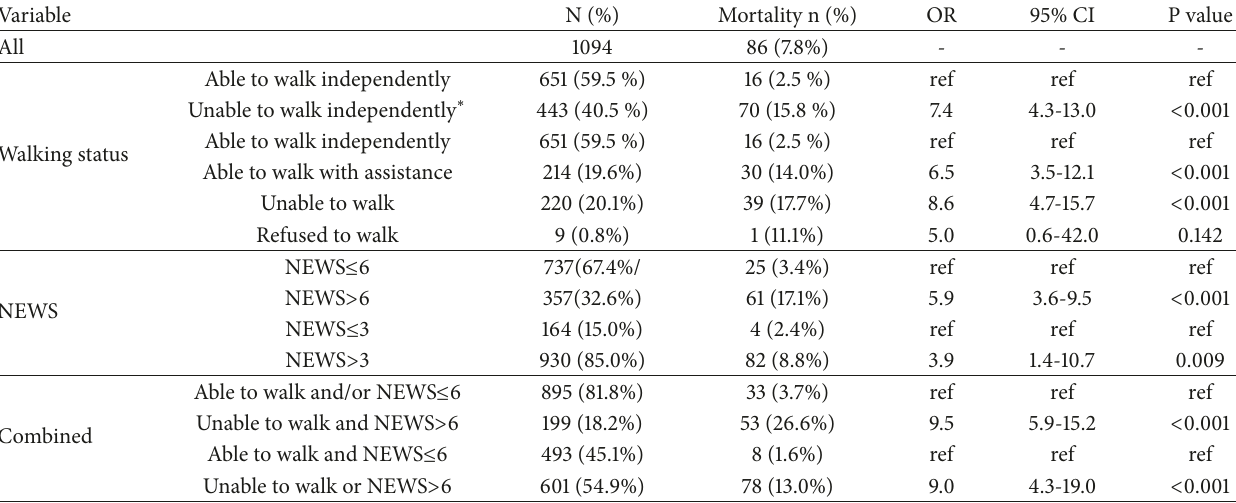
Table 2: In-hospital mortality by walking ability and